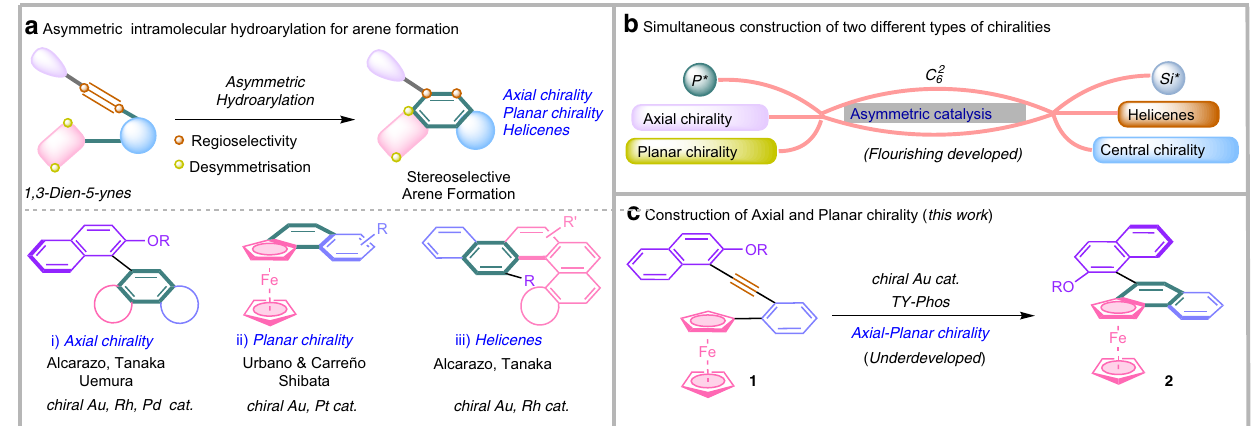
Fig. 1 Background and project synopsis. a Asymmetric intramolecular hydroarylation for arene formation. b Simultaneous construction of two different types of chiralities. c Construction of Axial and Planar chirality (this